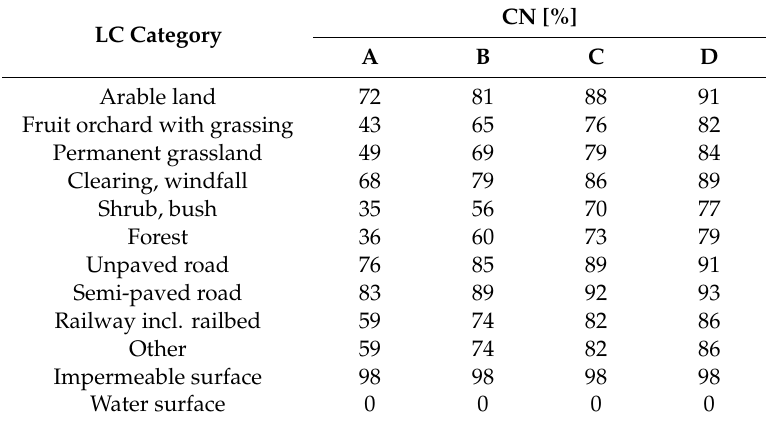
Table 2. Description of hydrologic soil groups (HSG)